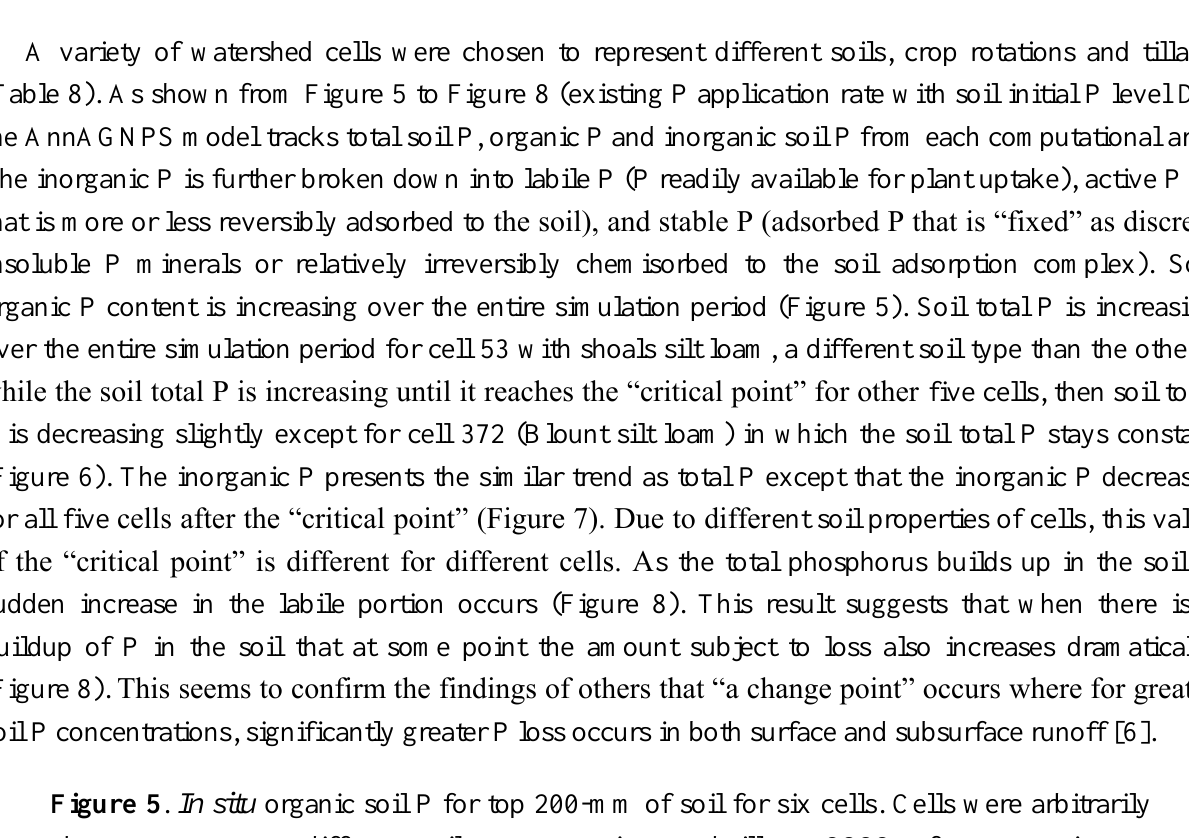
Figure 5 . In situ organic soil P for top 200-mm of soil for six cells. Cells were arbitrarily chosen to represent different soils, crop rotations and tillage. SSSS refers to continuous soybean during 1999–2002, CCSC refers to corn-corn-soybean-corn rotation